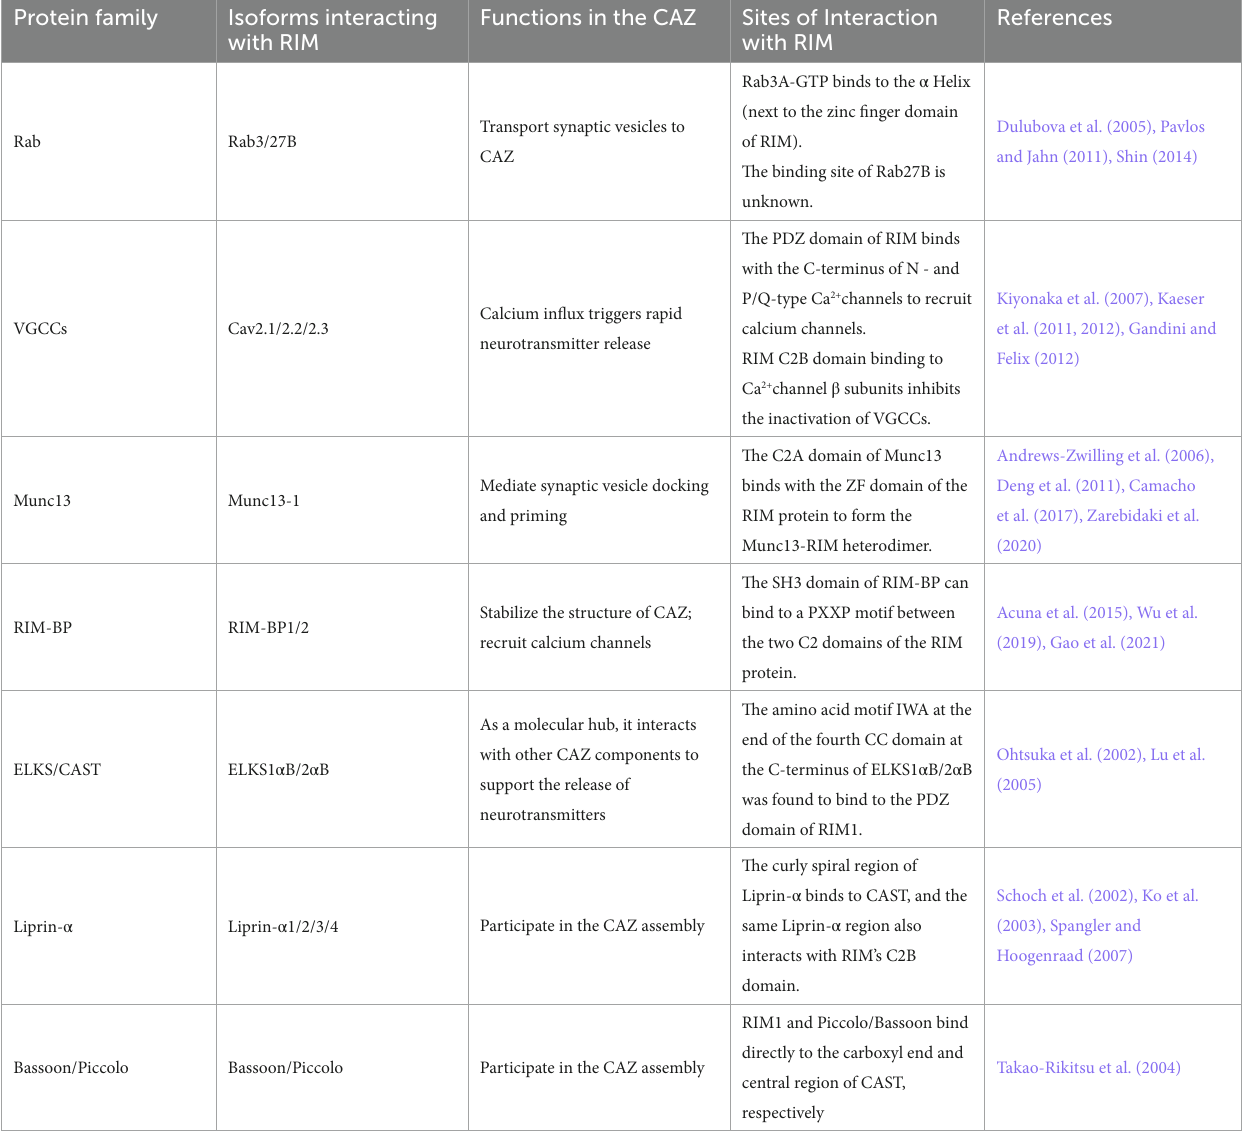
TABLE 2 Important elements in the active zone that interact with